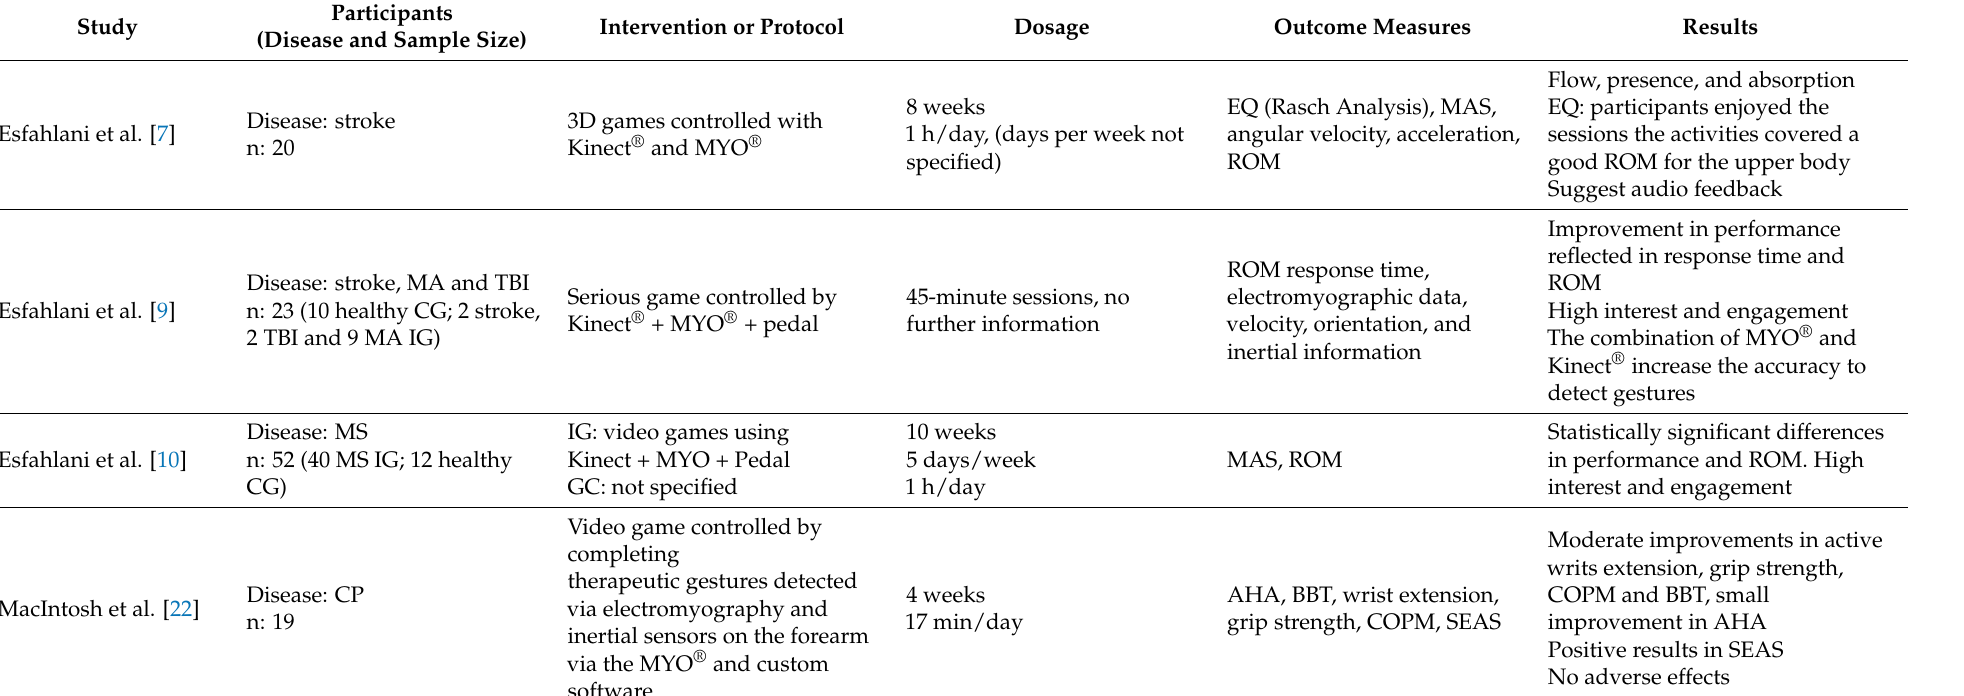
Table 3. Characteristics of the studies focused on the clinical effects of the device as a rehabilitation